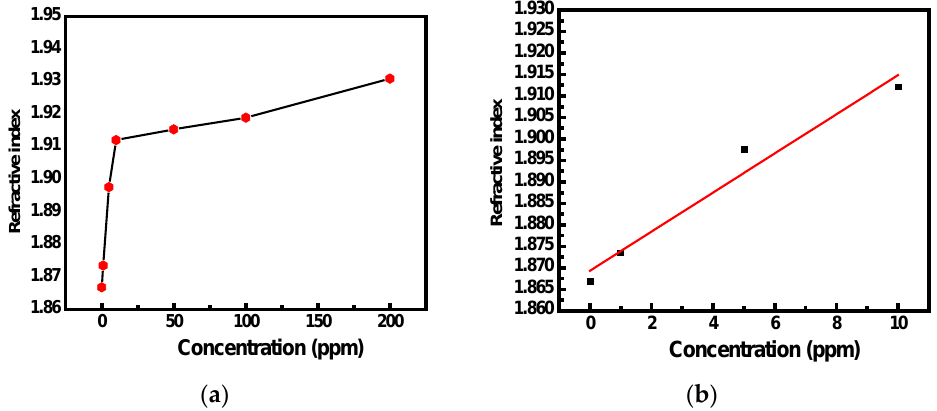
Figure 6. ( a ) Changes in the effective index of the (SnO 2 + PPy) interface caused by the adsorption of NH 3 gas with increasing concentration, and ( b ) changes in the refractive index up to a concentration of 10 ppm.